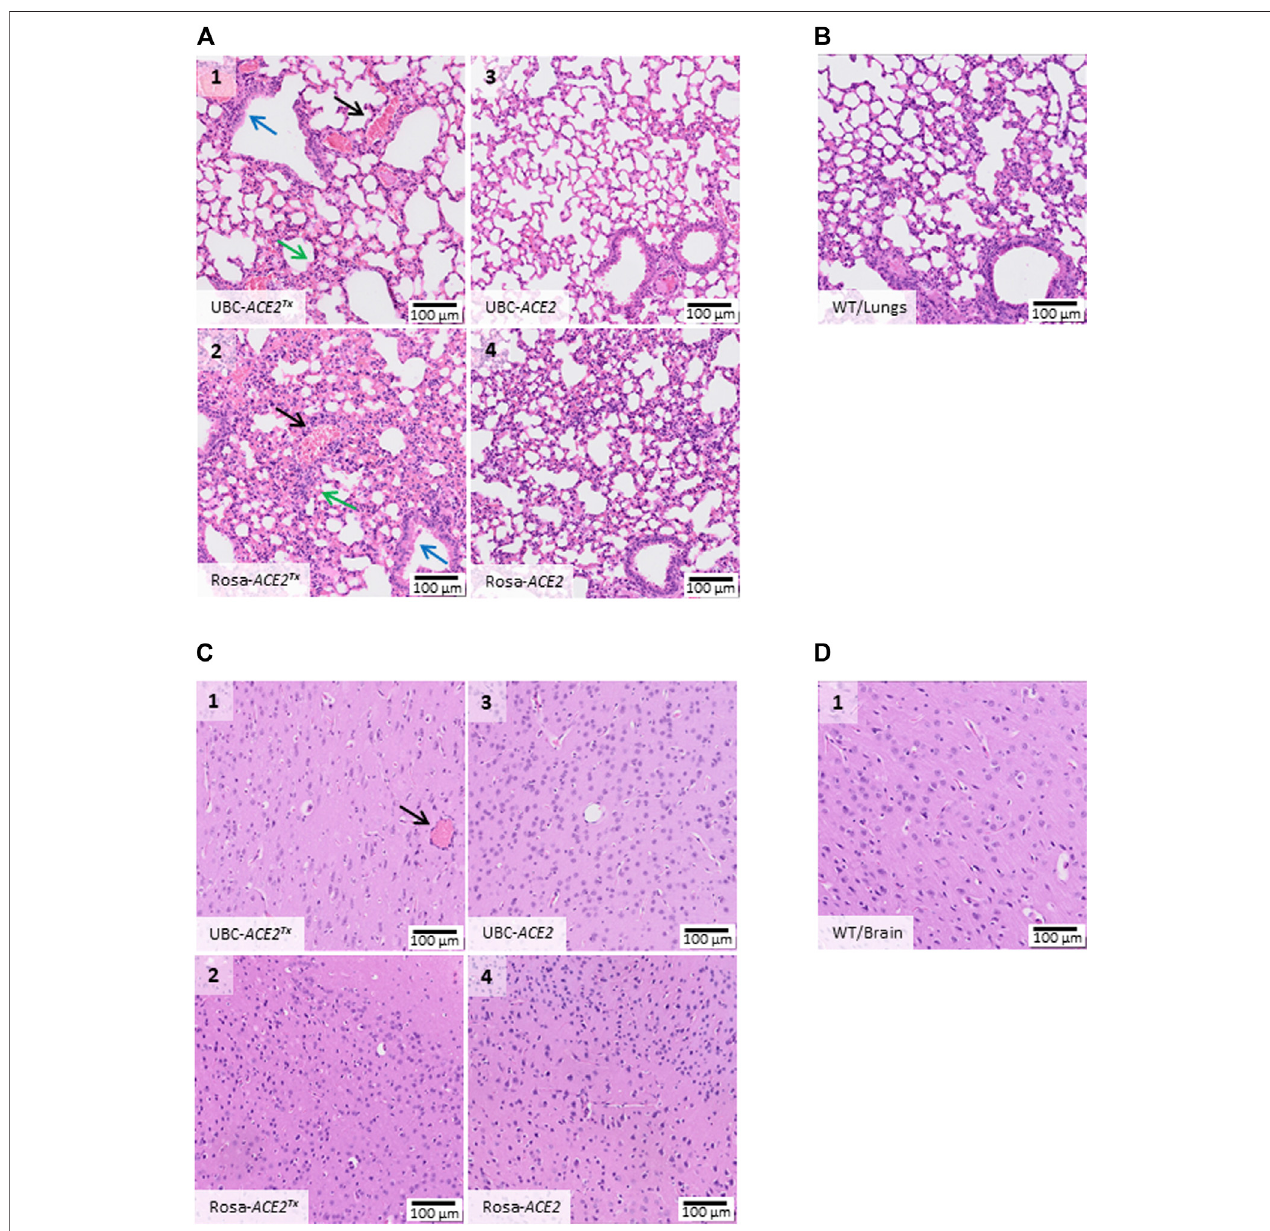
FIGURE 3 | Histological alterations in organs on the 5th day after SARS-CoV-2 inoculation. (A) Hematoxylin/eosin histostained lung tissue samples from UBC- ACE2 Tx (A1), UBC- ACE2 (A3), Rosa- ACE2 Tx (A2) and Rosa- ACE2 (A4) groups. (C) Hematoxylin/eosin histostained brain samples from the UBC- ACE2 Tx (C1), UBC- ACE2 (C3), Rosa- ACE2 Tx (C2) and Rosa- ACE2 (C4) groups. The pattern of pathological changes in UBC- ACE2 Tx (A1) and Rosa- ACE2 Tx (A2) lung samples included the septal thickening of alveolar ducts and sacs caused by the diffuse hyperplasia of type II alveolar epithelial cells with mild lymphocytic in fi ltration and edema (green arrow), hyperplasia of the epithelium of bronchioles (blue arrow) and multiple sludges of erythrocytes in vessels (black arrow). Examination of brain samples revealed multiplesludgesoferythrocytes(blackarrow)onlyinbrainvesselsofUBC- ACE2 Tx (C1)mice.InboththeUBC- ACE2 Tx − andRosa- ACE2 Tx- infectedgroups,tissuelesions were detected only after tamoxifen administration. (B) , (D) WT mice displayed no damage in the studied organs.